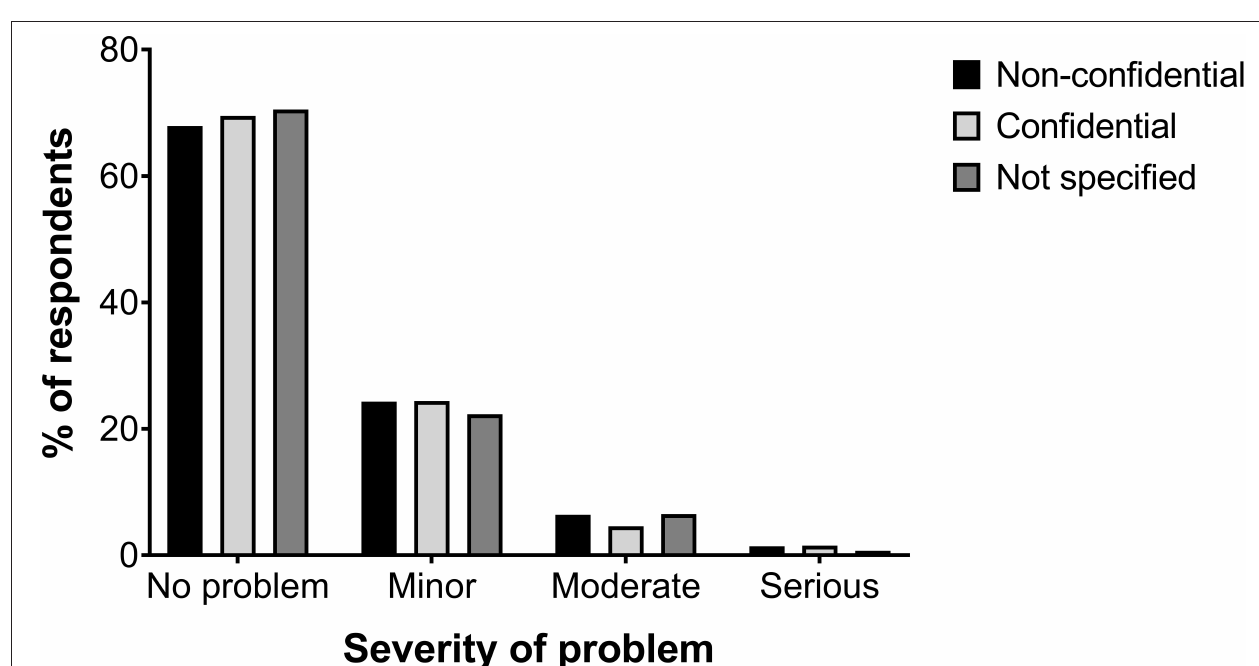
FIGURE 2 | Relinquishing owners’ perceptions of dog behavior based on the confidentiality of their survey responses.